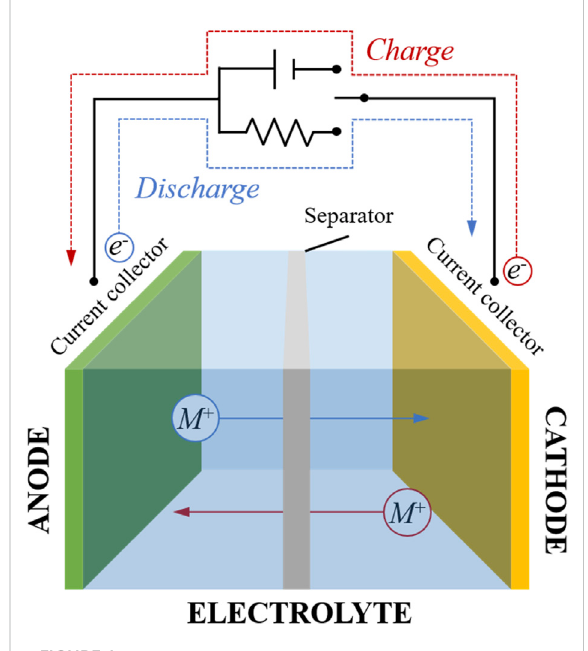
FIGURE 1 General schematic drawing of a metal (ion) battery operation where the metal can be replaced by lithium or